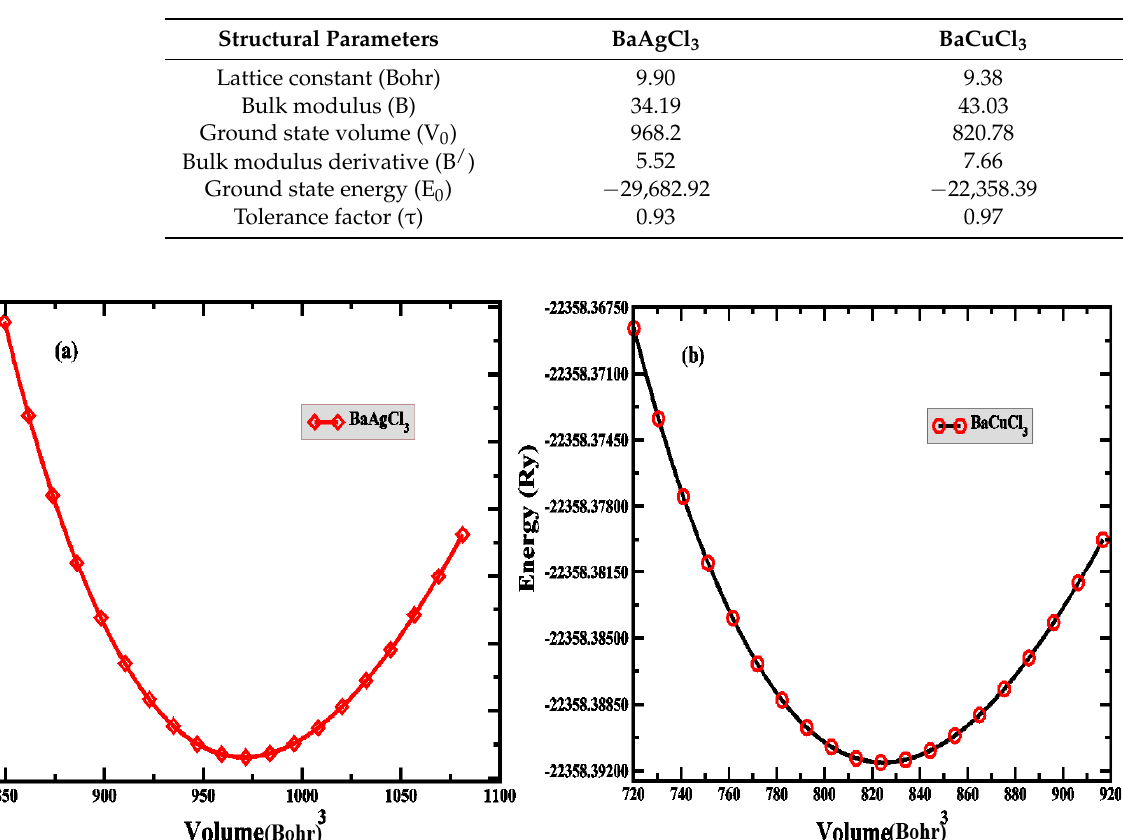
3 and ( b ) BaCuCl 3